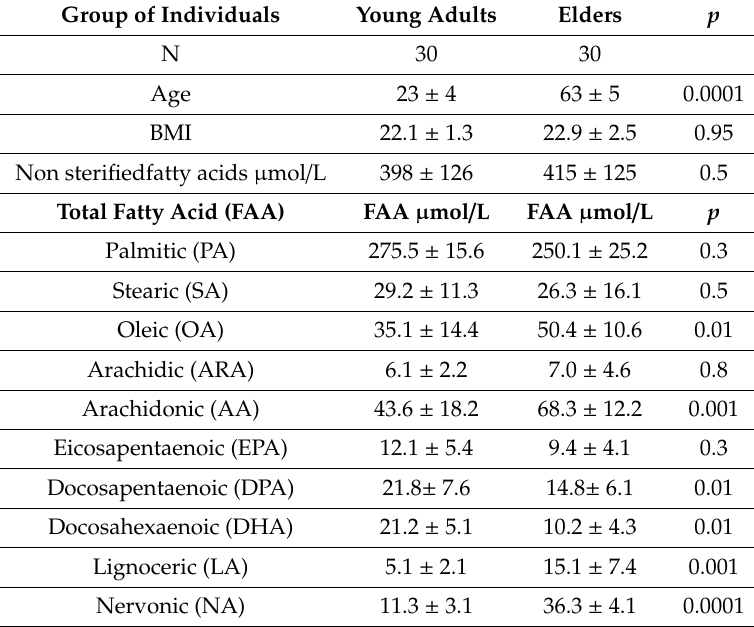
Table 1. Plasma fatty acids levels comparison between the two groups of healthy